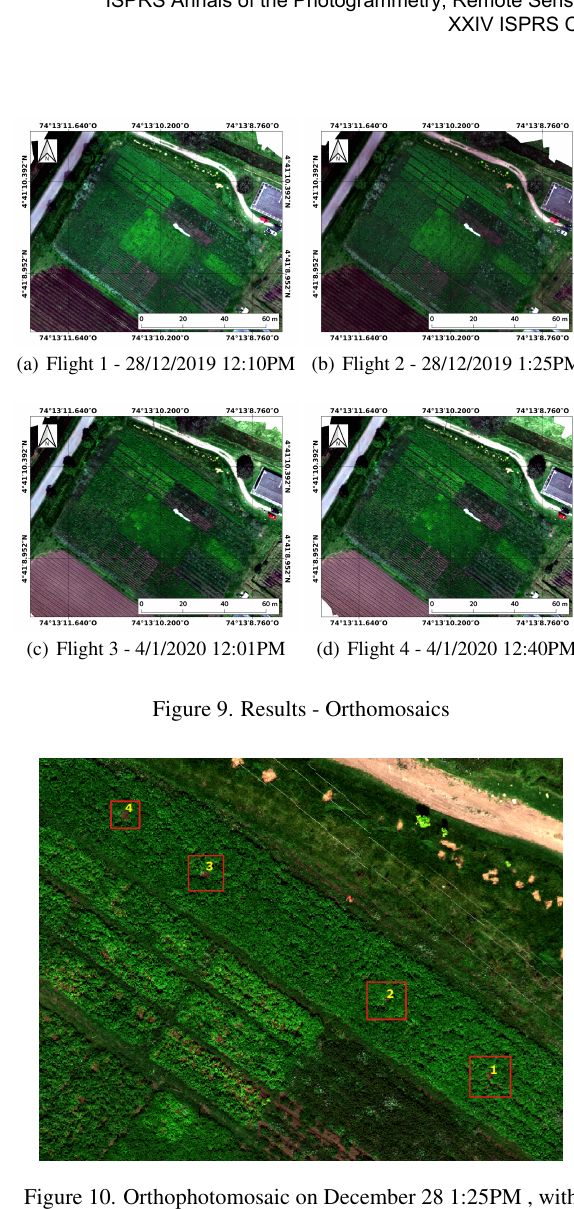
Figure 10. Orthophotomosaic on December 28 1:25PM , with identification of areas of surface elevation change due to individual plants removal (GMT-5).